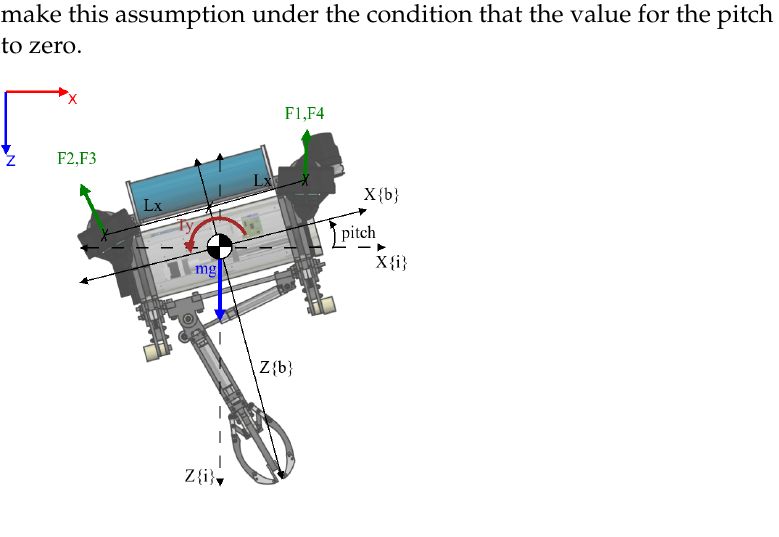
Figure 4. The applied forces visible on the X–Z plane of the body-fixed